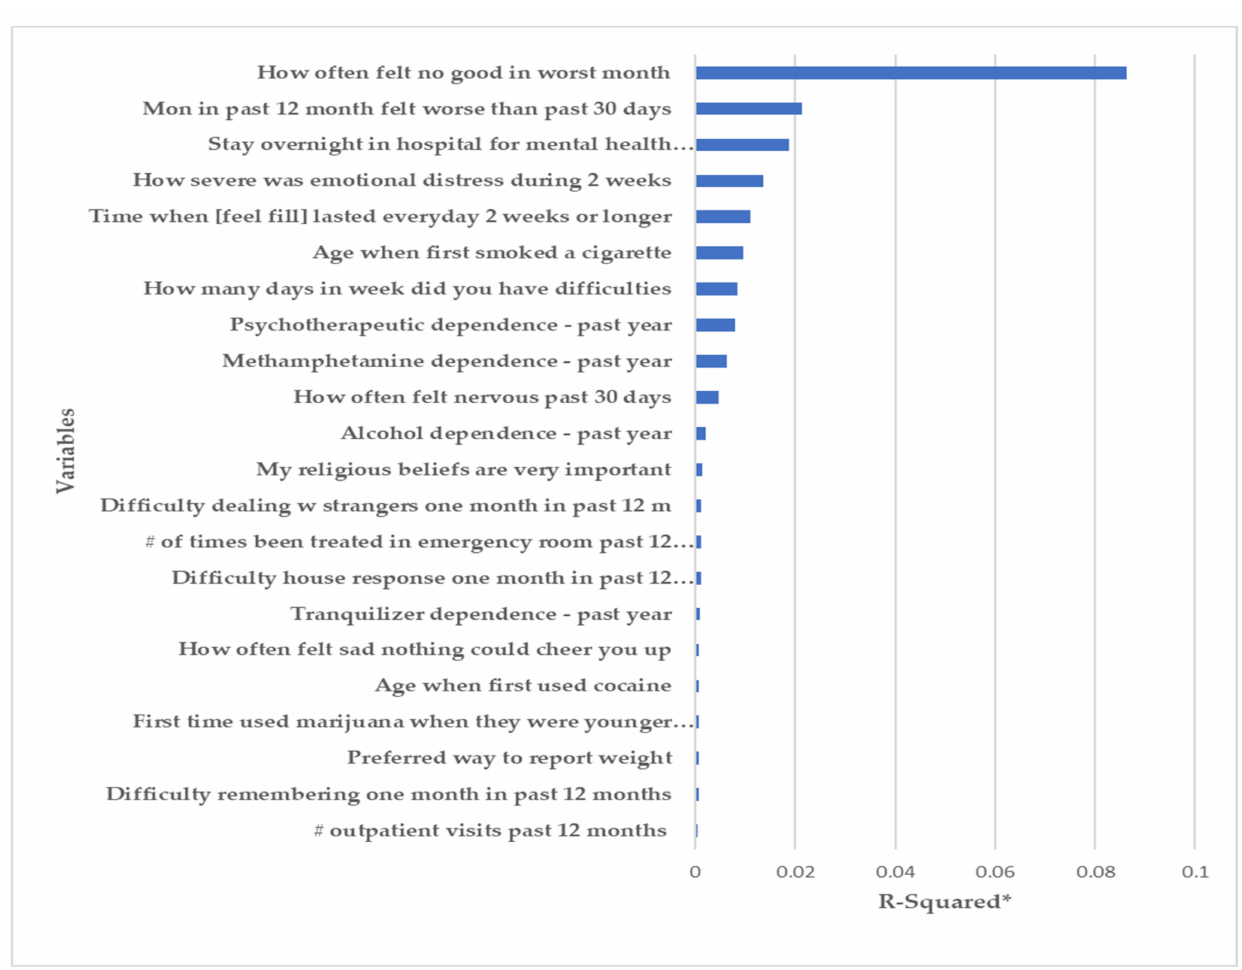
Figure 3. Importance plot for the suicide risk (* a larger R-squared value means that a variable explains a larger percentage of the variation in the outcome